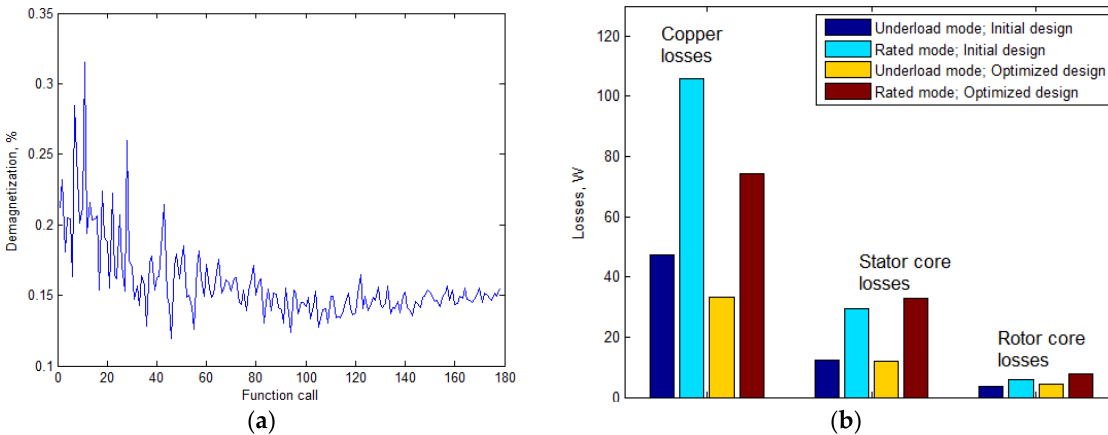
Figure 8. ( a ) Variation of the demagnetization percentage during the optimization; ( b ) losses of both FRMs in two modes.